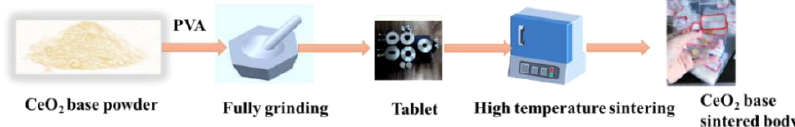
Figure 2. Flow chart of preparation of CSYG-BIT07.